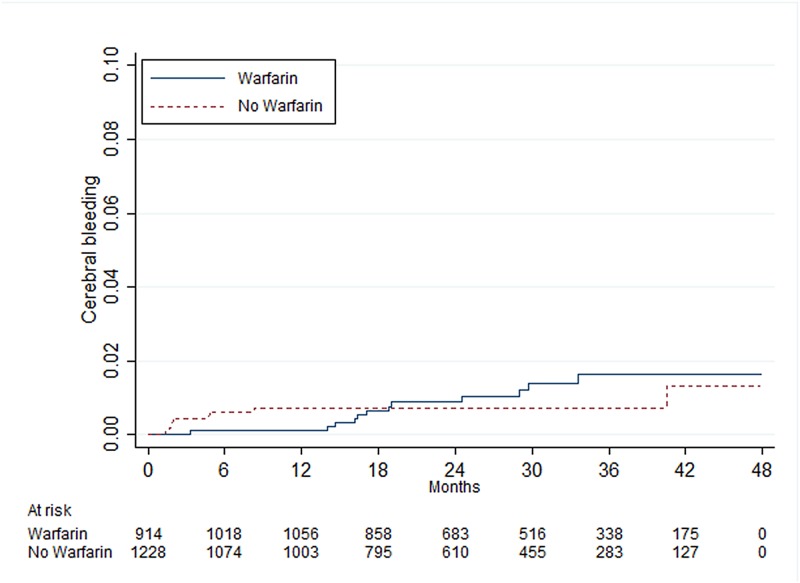
Risk of cerebral bleeding in men <65 years of age with atrial fibrillation and one additional point from the CHA2DS2-VASc score other than sex or agea.aOne additional point indicates congestive heart failure, hypertension, diabetes mellitus or vascular disease.